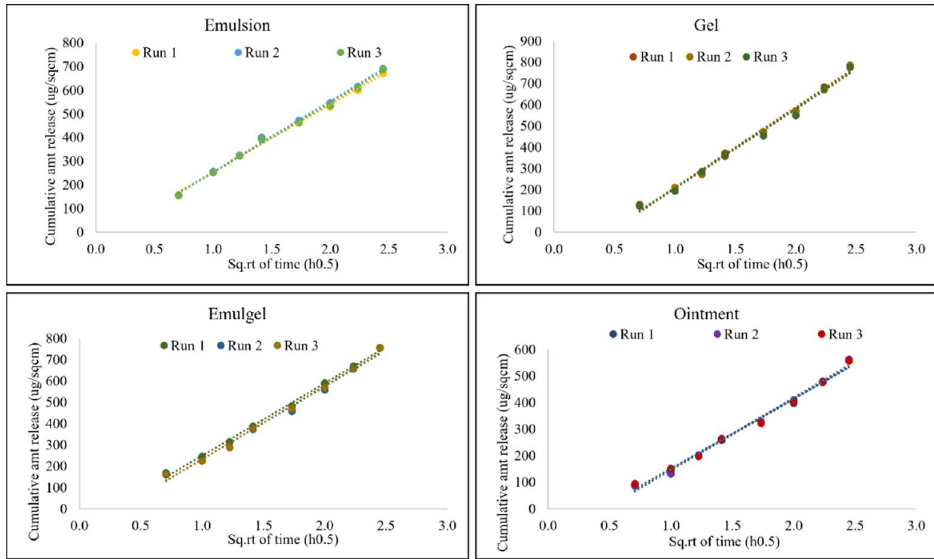
Figure 4. Intra-day precision for all semi-solid formulations. Data shown as mean release rate (µg/cm 2 /min 0.5 ) and % RSD for six replicates.